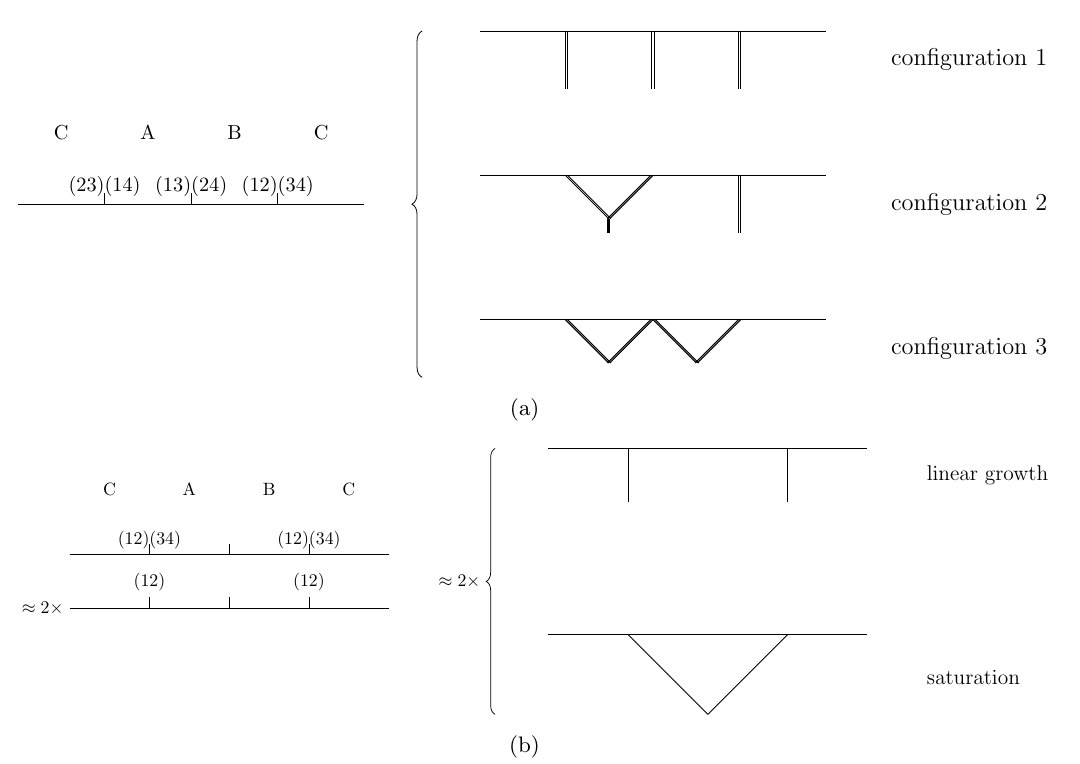
Figure 14 . Space time domain wall structures for the two terms in eq. (3.1). According to our convention, the domain wall starts from the top boundary and go downward. (a) Domain wall con(cid:12)gurations for the operator R(cid:19)enyi operator entanglement of unnormalized state (1st term